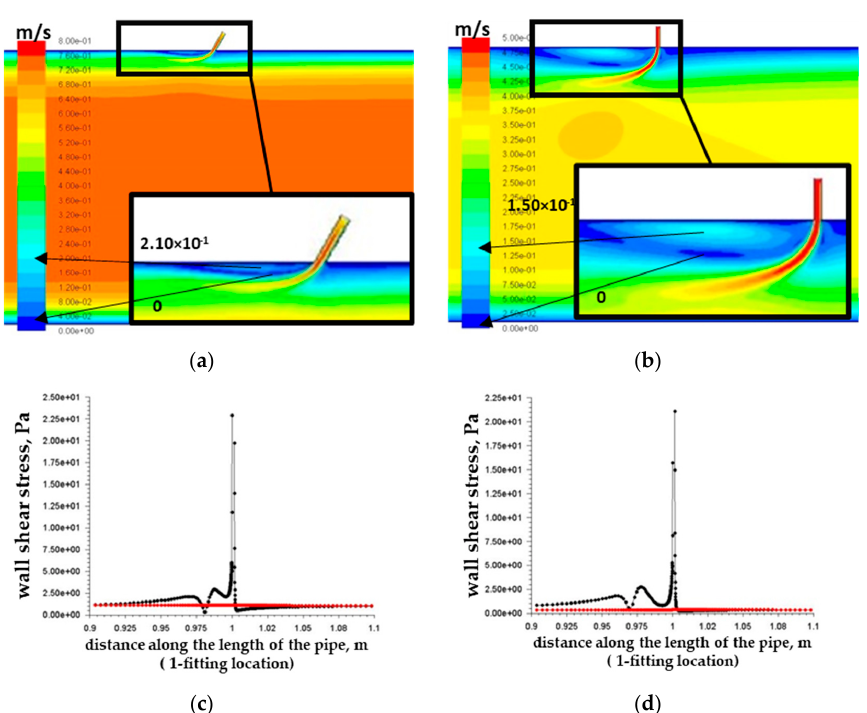
Figure 5. Velocity modulus field in the vertical section of the pipe for the variant of the nozzle-type ICD channel inclination angle of 60° and fluid velocity at the pipe inlet of 0.662 m/s ( a ) and 0.297 m/s ( b ); graphs of shear stresses on the pipe walls at 0.1 m from the nozzle of fluid velocity at the pipe inlet of 0.662 m/s ( c ) and 0.297 m/s ( d ). The black lines correspond to the wall on which the nozzle-type ICD is located, and the red lines correspond to the opposite wall.